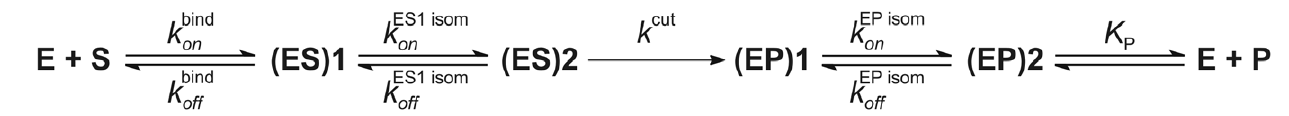
Figure 5. The kinetic scheme describing the interactions of APE1K98A with specific F- and AP-substrates during BER.